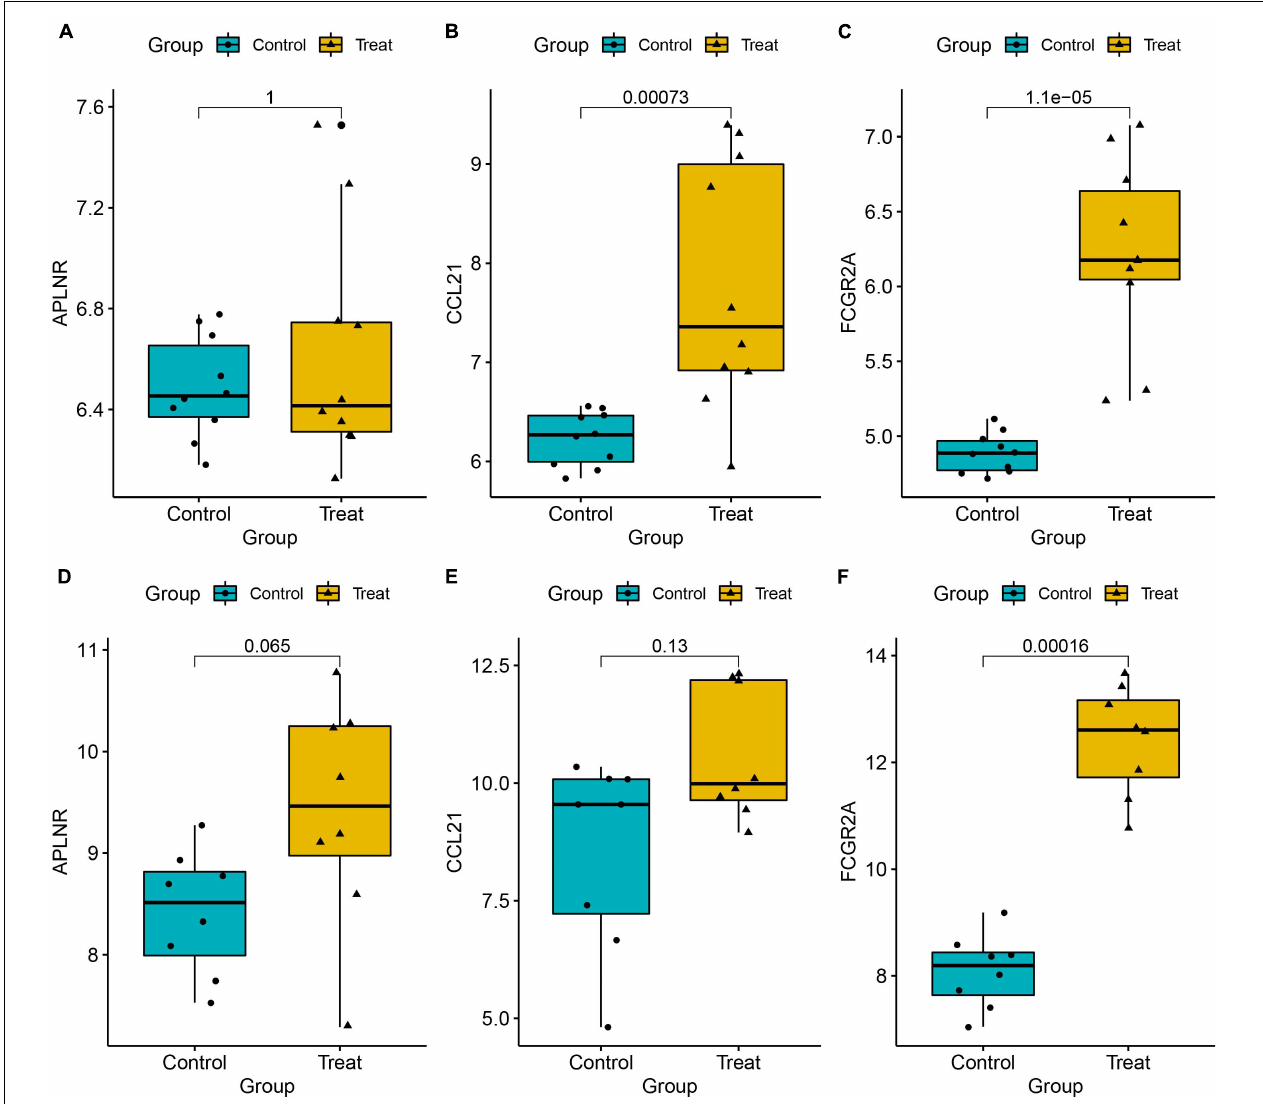
FIGURE 9 | Expression levels for three key genes, namely APLNR (A,D) , CCL21 (B,E) , and CCL21 (C,F) , between EM and normal tissues. Validation was done using two external datasets (GSE7305 and